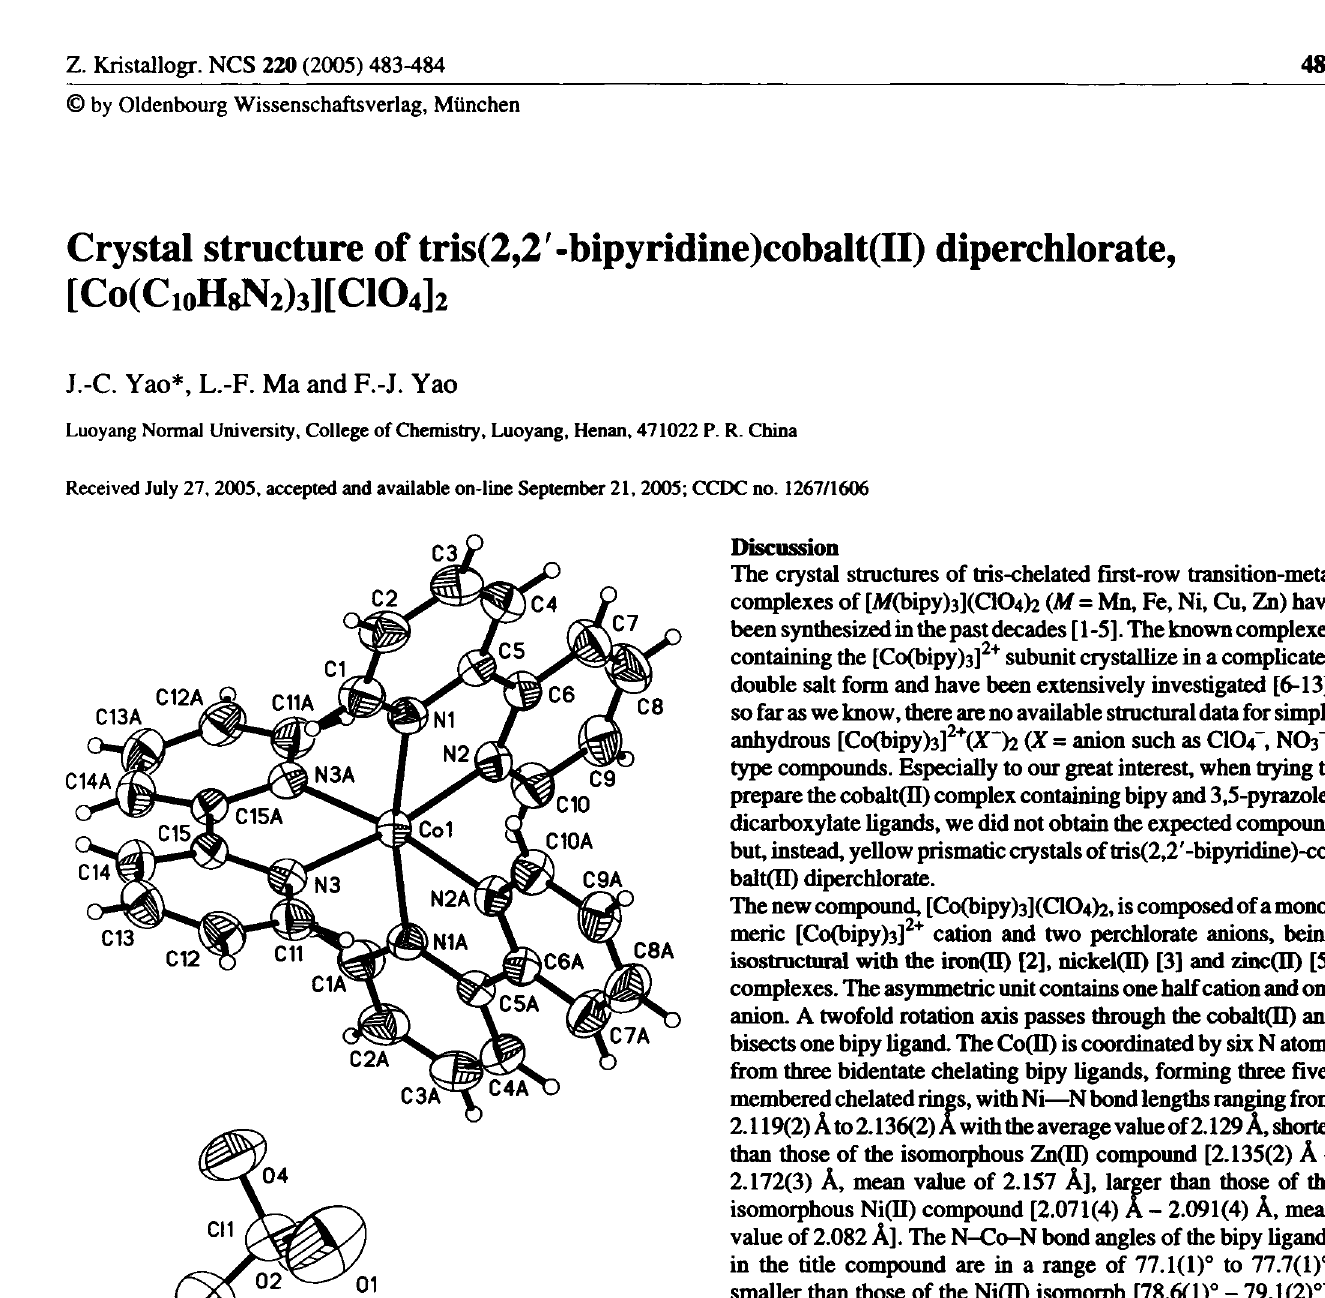
Table 1. Data collection and